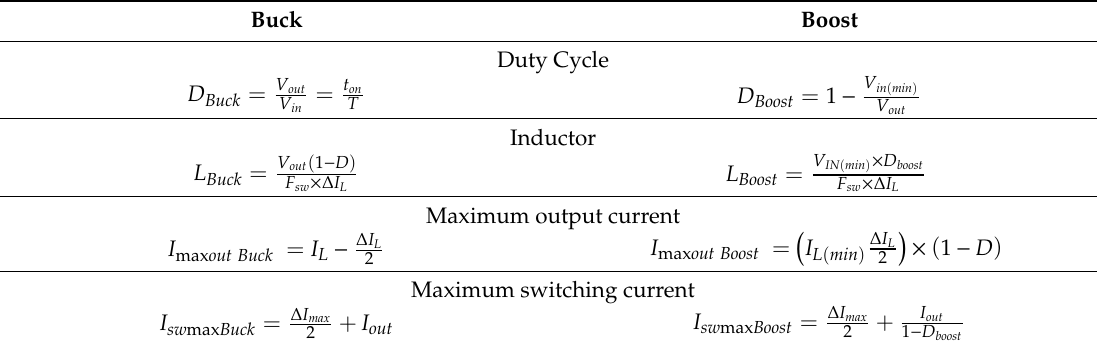
Table 1. Buck and Boost mode of